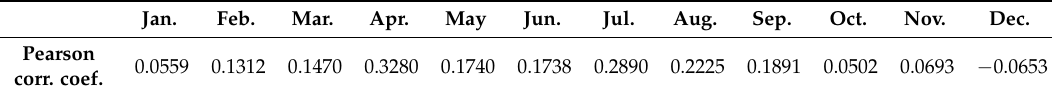
Table 1. Correlation between average daily beverage sales and average daily temperatures, by